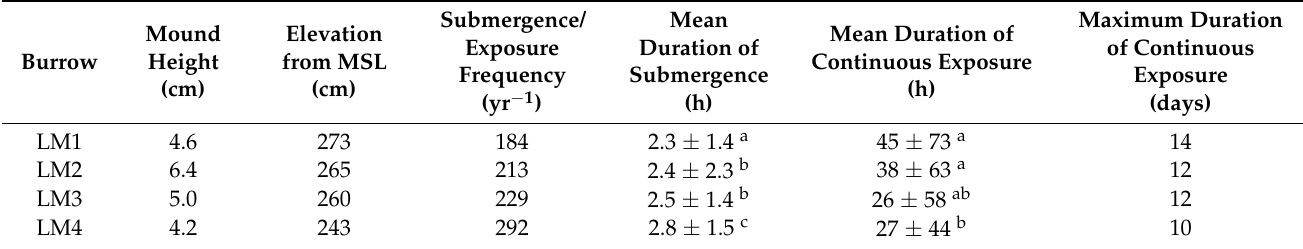
Table 1. Comparison of tidal conditions among burrows. Different superscripts indicate significant differences among burrows ( p < 0.05), while superscript ab indicates no significant difference from a and b.